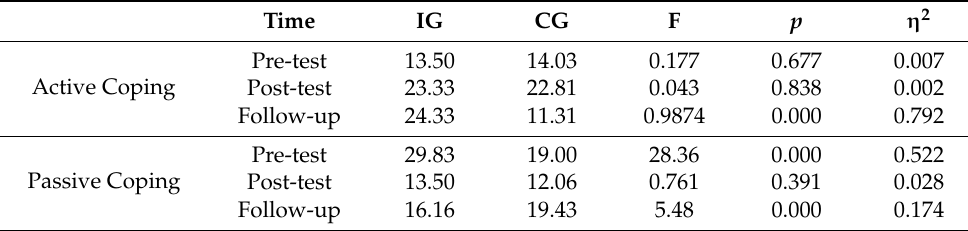
Table 7. Mean active and passive coping at the three times measures and